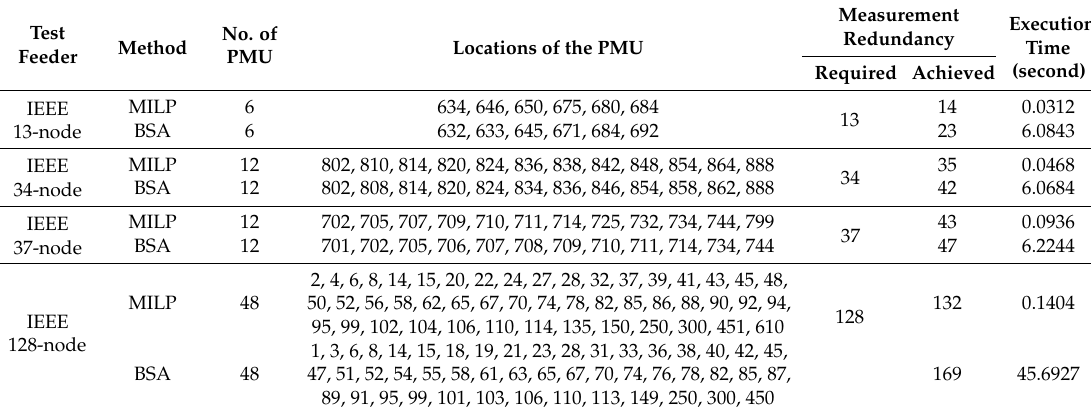
Table 2. Optimal numbers and locations of PMU without considering ZIB and channel limits during the normal operating mode.